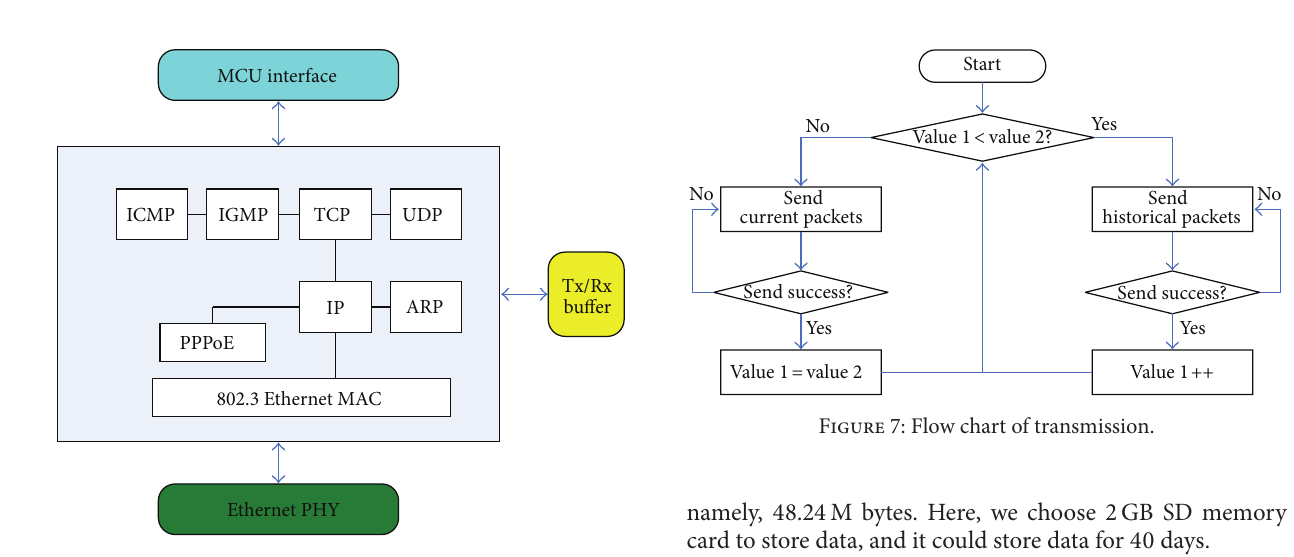
Figure 6: Block diagram of internal W5100.